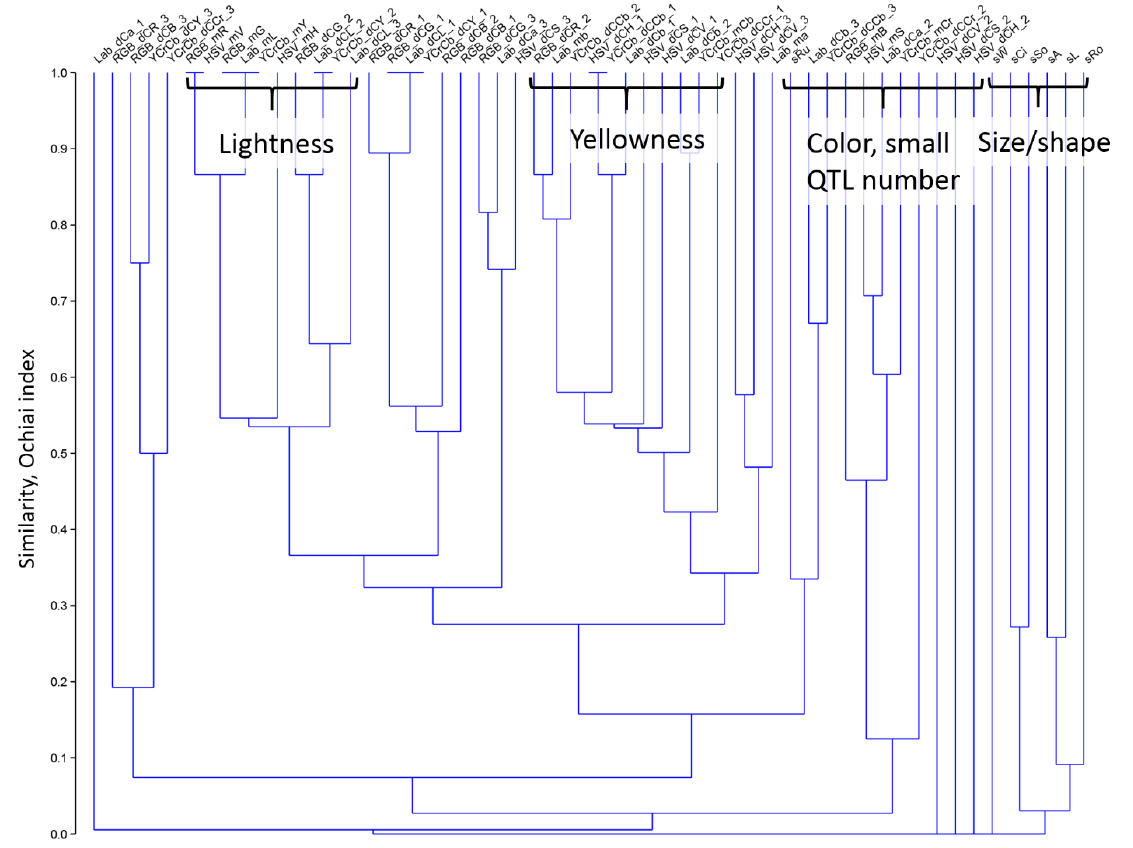
Figure 6. The similarity tree for seed traits obtained by the degree of the overlap between their QTL locations. The vertical axis represents the similarity measure based on the Ochiai index (Y axis). Leaves correspond to seed traits described in [1] ( for trait abbreviation, see Section 4.2. Quantitative Characteristics of Seed Shape, Size and Color ). Groups of traits with strong overlapping of the QTL locations are shown by curly brackets.